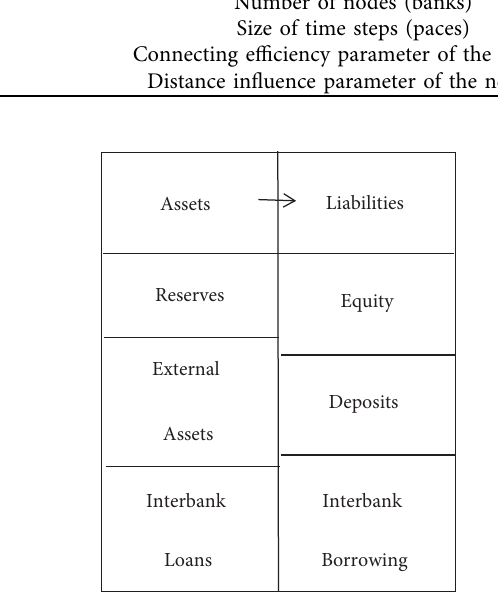
Figure 1: The stylized balance sheet of bank i ∈ ℵ